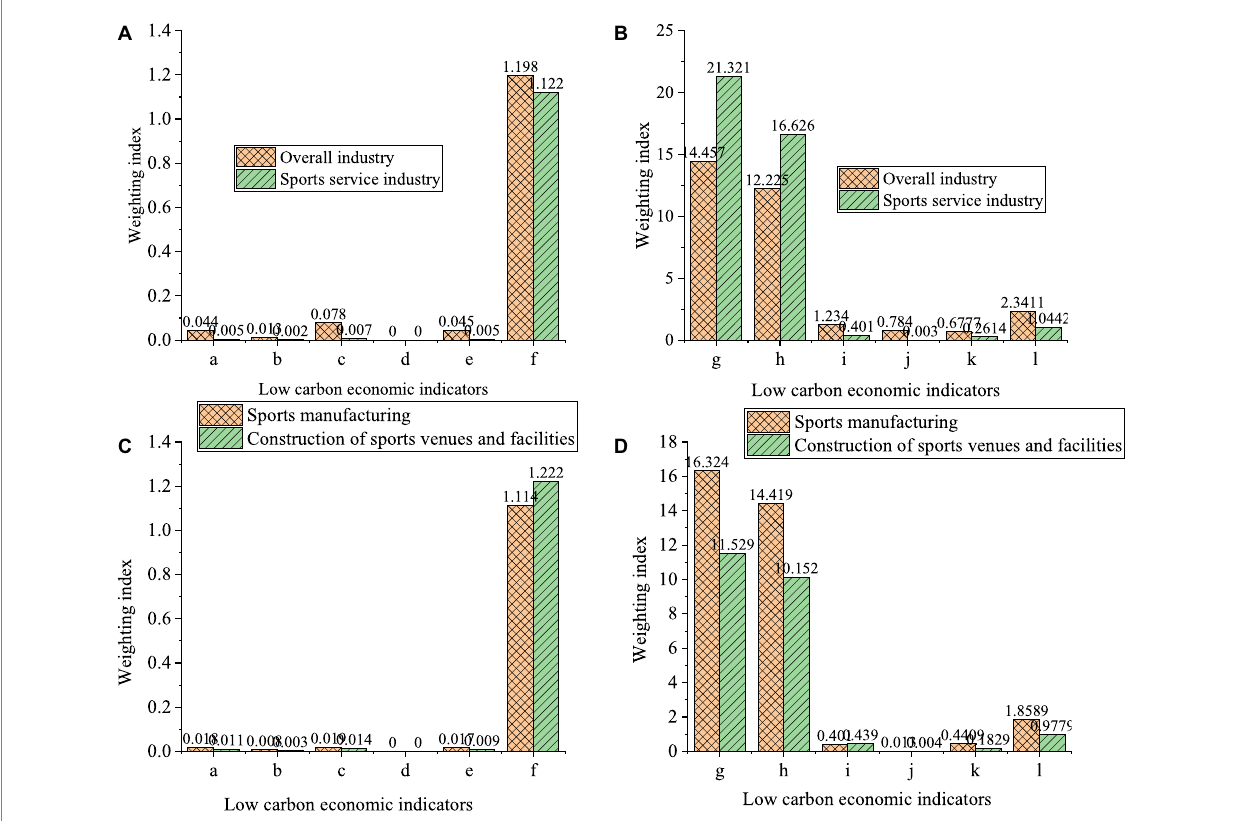
FIGURE 4 Development status of the sports industry and M enterprise (A,B) refer to the overall sports industry and sports service industry, and (C,D) is the sports manufacturing industry and the construction of sports venues and facilities.